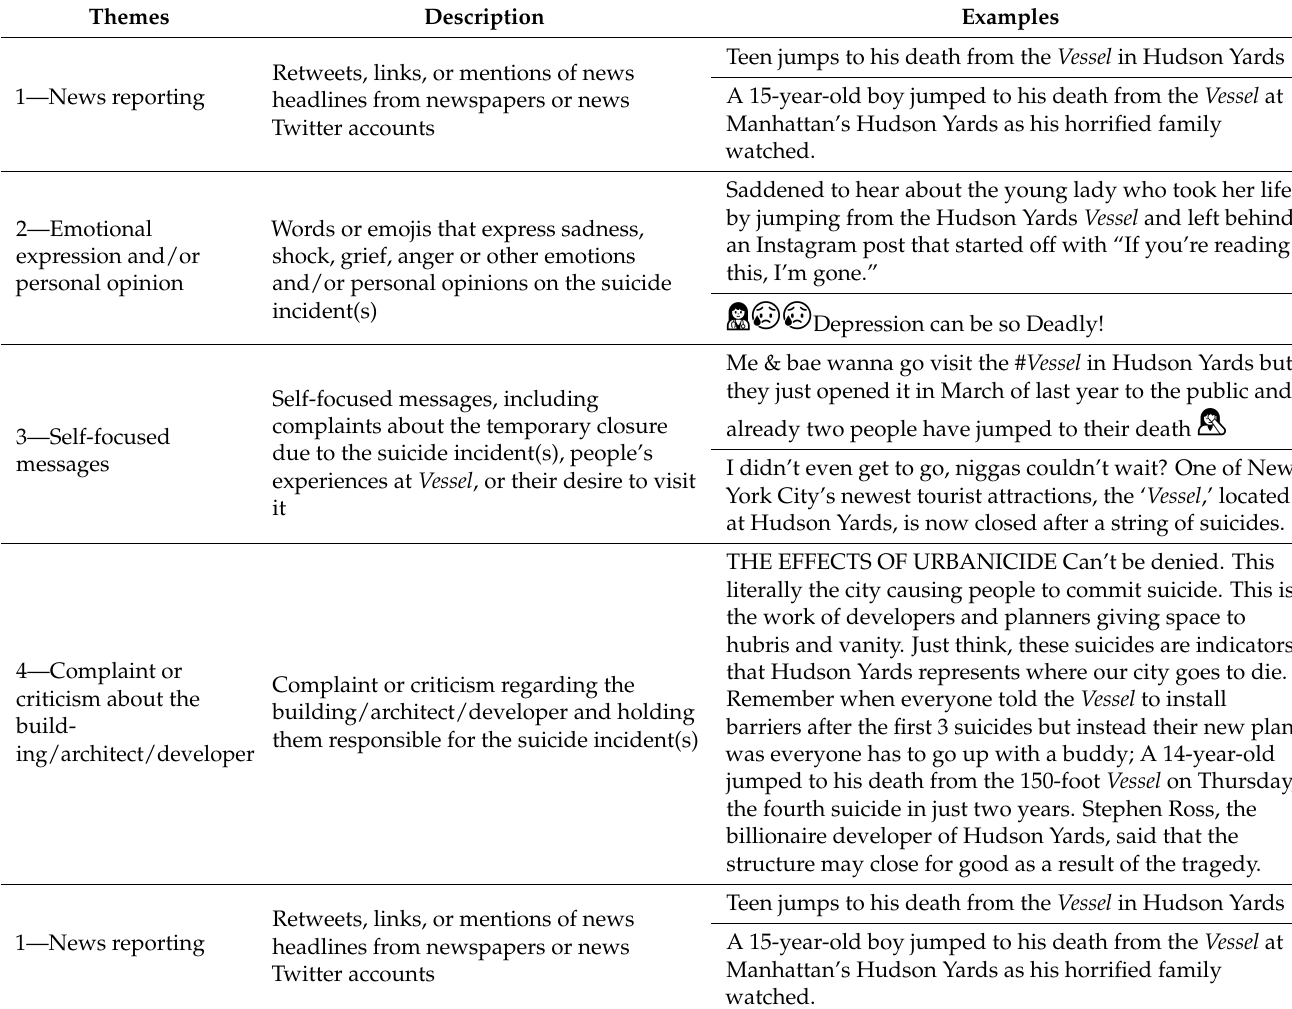
Table A1. Thematic analysis codebook with examples of tweets.